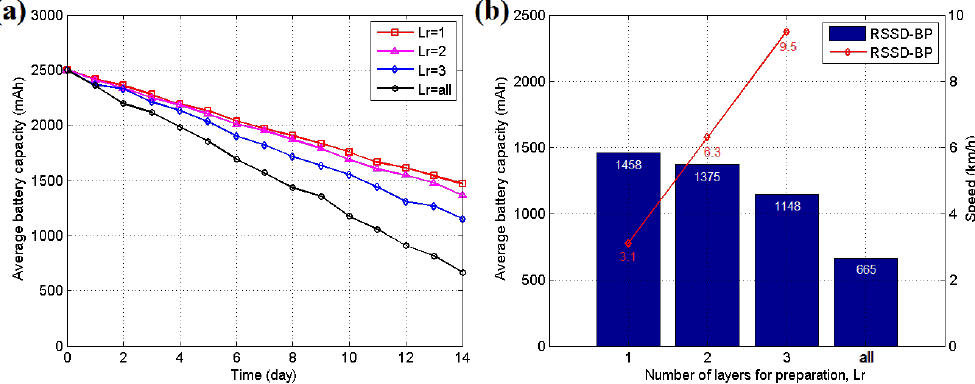
Figure 22. ( a ) Average battery capacity curve for different awakened parameters in testing scenario 2; ( b ) Final average battery capacity and target speed restriction for different awakened parameters in testing scenario 2.